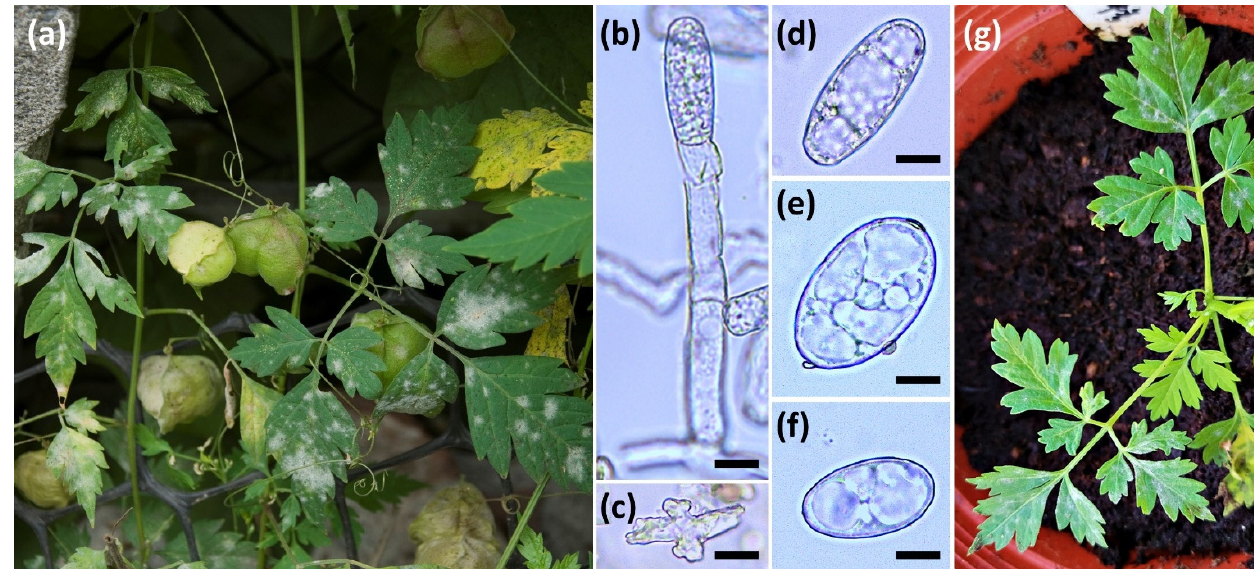
Figure 6. Erysiphe neolycopersici on Cardiospermum halicacabum . ( a ) Symptoms of the powdery mildew on naturally infected plant in field. ( b – f ) Micrographs of E. neolycopersici on C. halicacabum TNM 0035016. ( b ) Conidiophore with conidium. ( c ) Hyphal appressoria. ( d – f ) Conidia. ( g ) The symptoms on C. halicacabum inoculated with E. neolycopersici on C. halicacabum . Scale bars in ( b – f ) = 10 μ m.